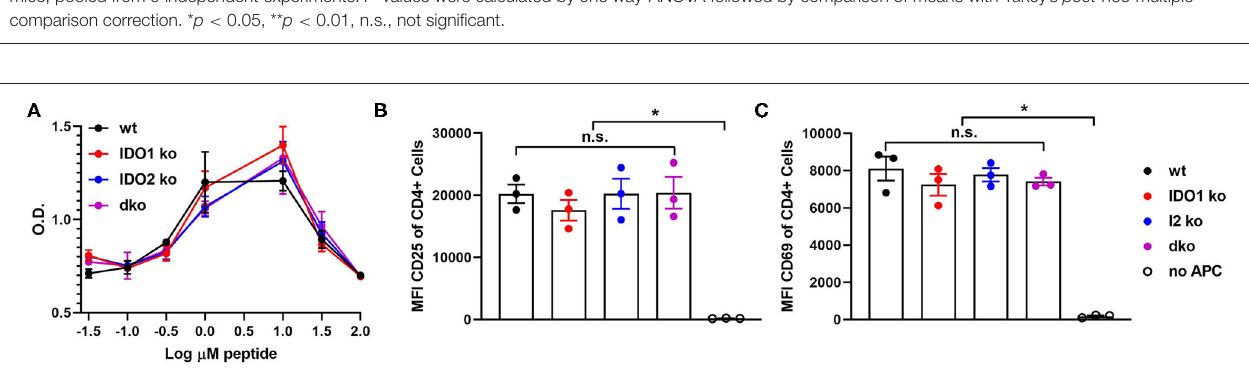
FIGURE 4 | Antigen presenting function is not affected by deletion of IDO1 or IDO2. Naive KRN T cells were cultured with irradiated splenocytes from wt, IDO1 ko, IDO2 ko, or dko C57BL/6.g7 mice and GPI peptide. (A) Proliferation was measured by the MTS assay at 72h. Graph is from a representative experiment of 3 total showing mean O.D. ± SD from 3 replicate wells. (B,C) Upregulation of the activation markers CD25 and CD69 were measured by flow cytometry at 48h. Symbols represent individual mice and histograms show mean fluorescence intensity (MFI) ± SEM from 3 individual experiments. P -values were calculated by one way-ANOVA followed by comparison of means with Tukey’s post-hoc multiple comparison correction. * p < 0.05, n.s., not significant.